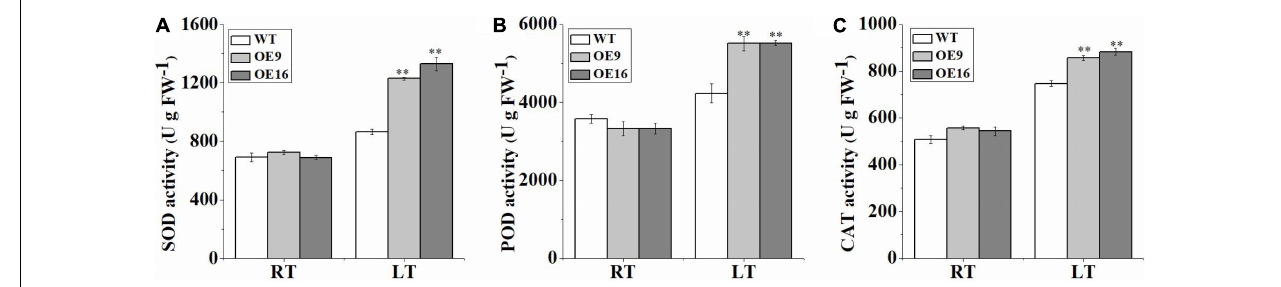
FIGURE 6 | The activities of the antioxidant enzymes SOD (A) , POD (B) , and CAT (C) in the wild-type (WT) and transgenic plants exposed to 4 ◦ C for 1 day. The error bars represent the standard errors of three independent tests and the asterisks ( ∗∗ ) indicate significant differences from the WT at p < 0.01.